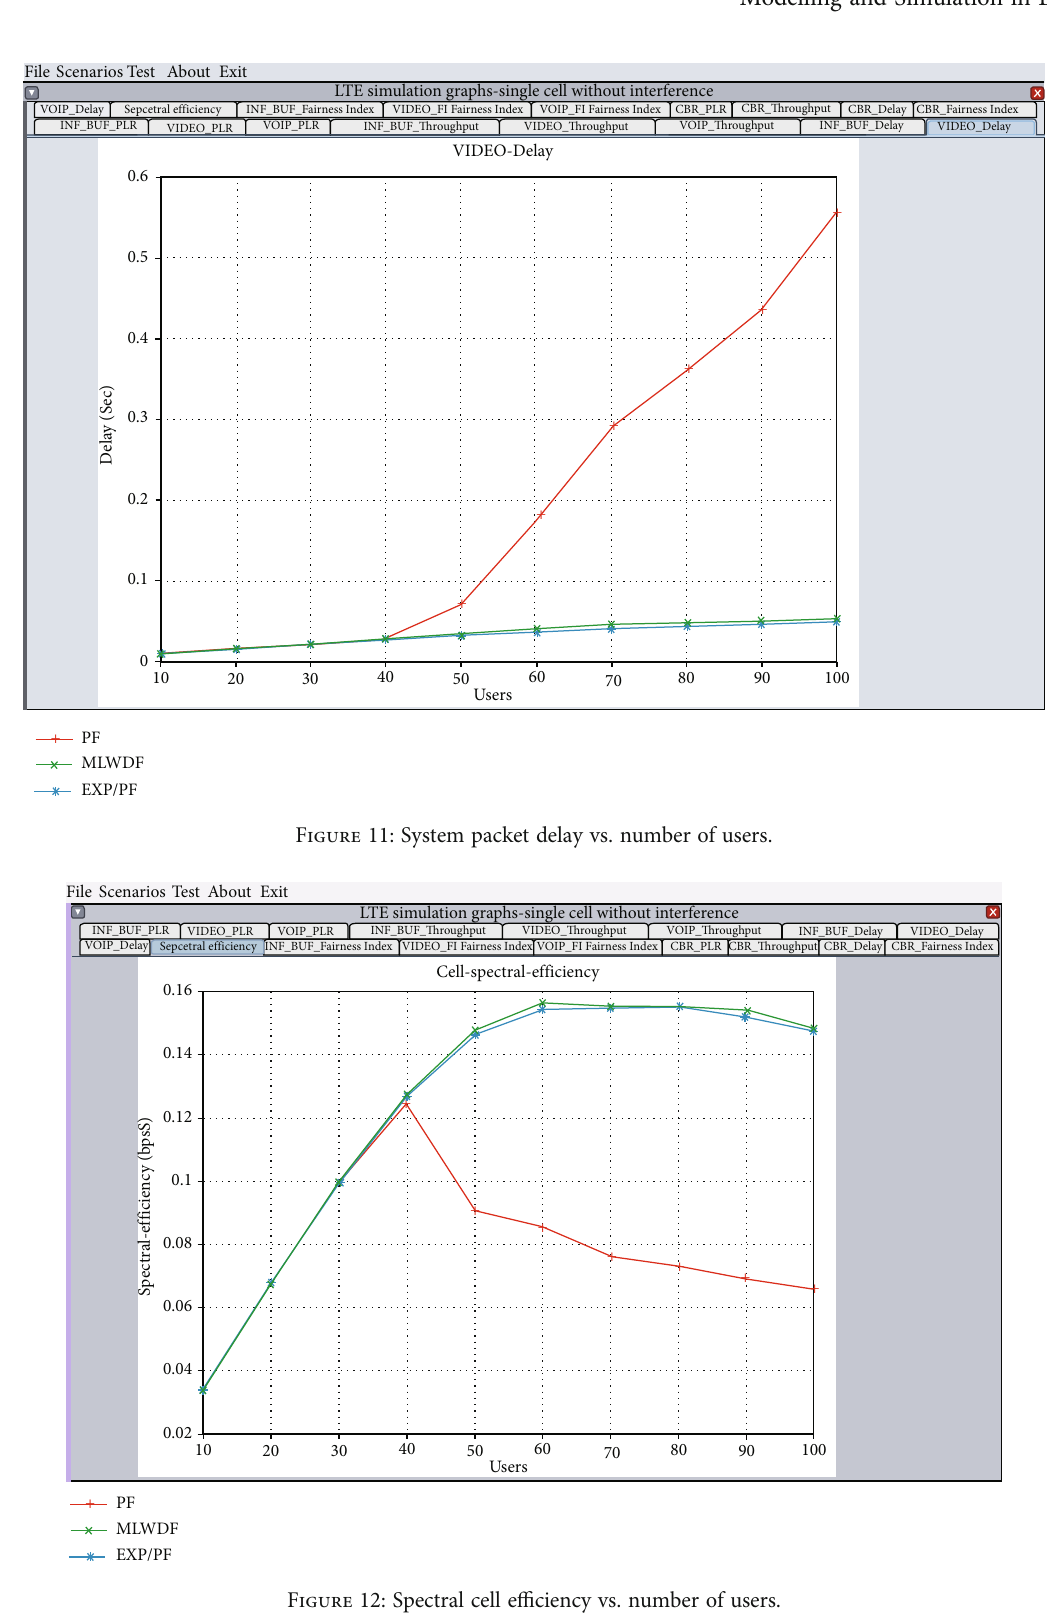
Figure 12: Spectral cell e ffi ciency vs. number of